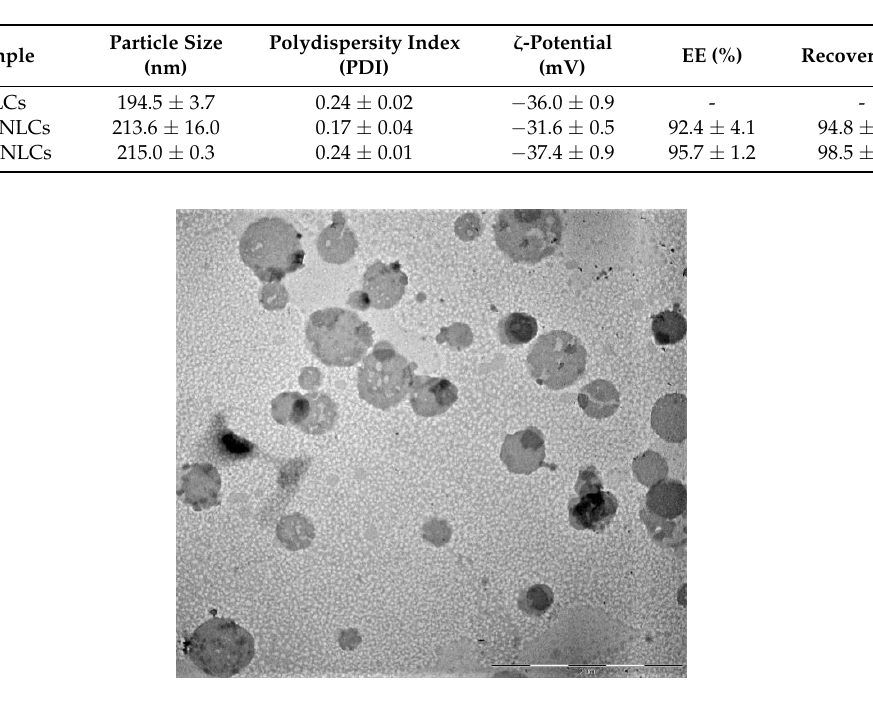
Table 3. Physicochemical characterization and reaction yields of SLM-NLCs after freeze-drying process. Light Scattering and High performance liquid chromatography (HPLC) analyses were performed after reconstitutions of the samples in water. Results are expressed as means ± standard deviation, n = 3. Freeze-Dried Product